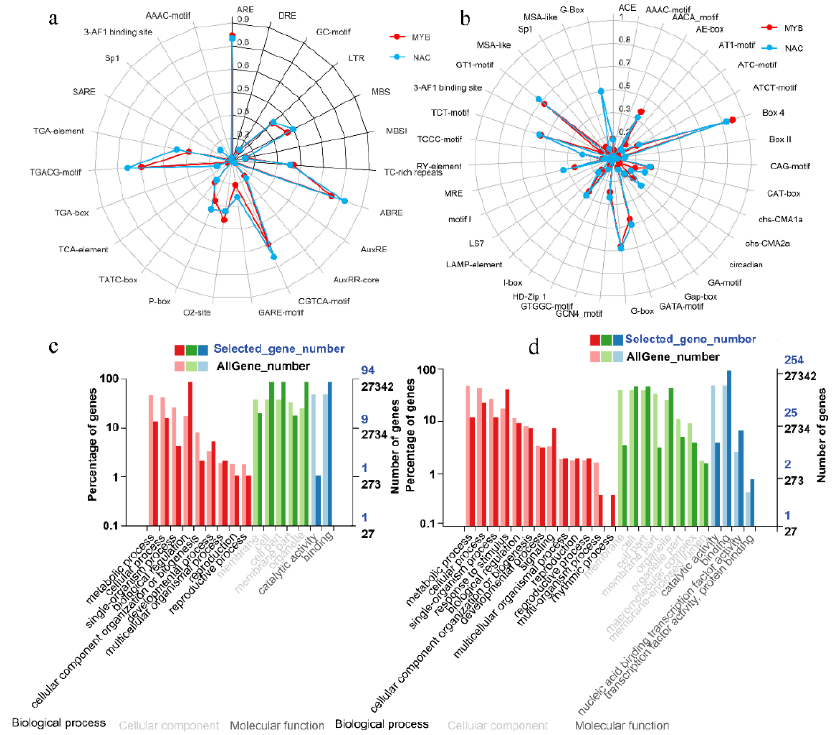
Figure 5. Statistics of cis-elements within the 2-kb promoter regions and functional classification of the MaNAC and MaMYB genes. ( a ) Stress- and hormone-responsive cis-elements within the promoter regions of the MaNAC and MaMYB genes. The blocks of black lines are stress-responsive cis-elements, while the blocks of gray lines are hormone-responsive cis-elements. ( b ) Development-responsive cis-elements within the promoter regions of the MaNAC and MaMYB genes. The red line represents MaMYB s, and the blue line represents MaNAC s. ( c ) MaNAC GO functional classification. ( d ) MaMYB GO functional